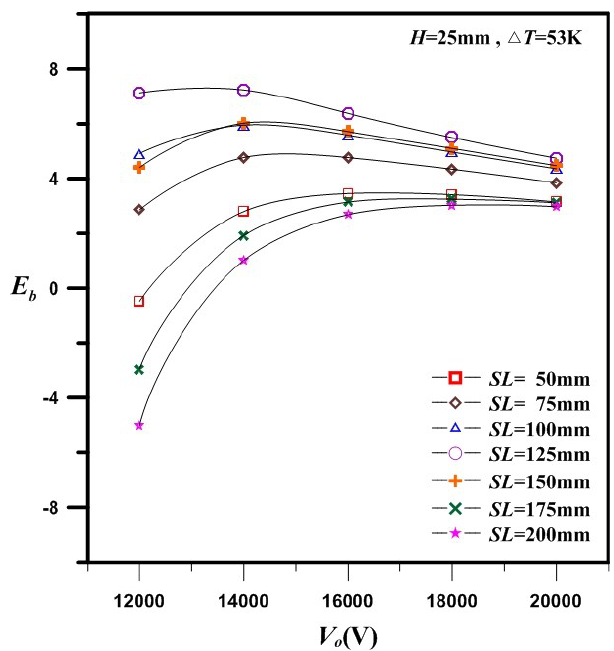
Figure 14. Variations in E b versus applied voltages V 0 for different electrode pitches SL ( H = 25 mm and Δ T = 53 K).